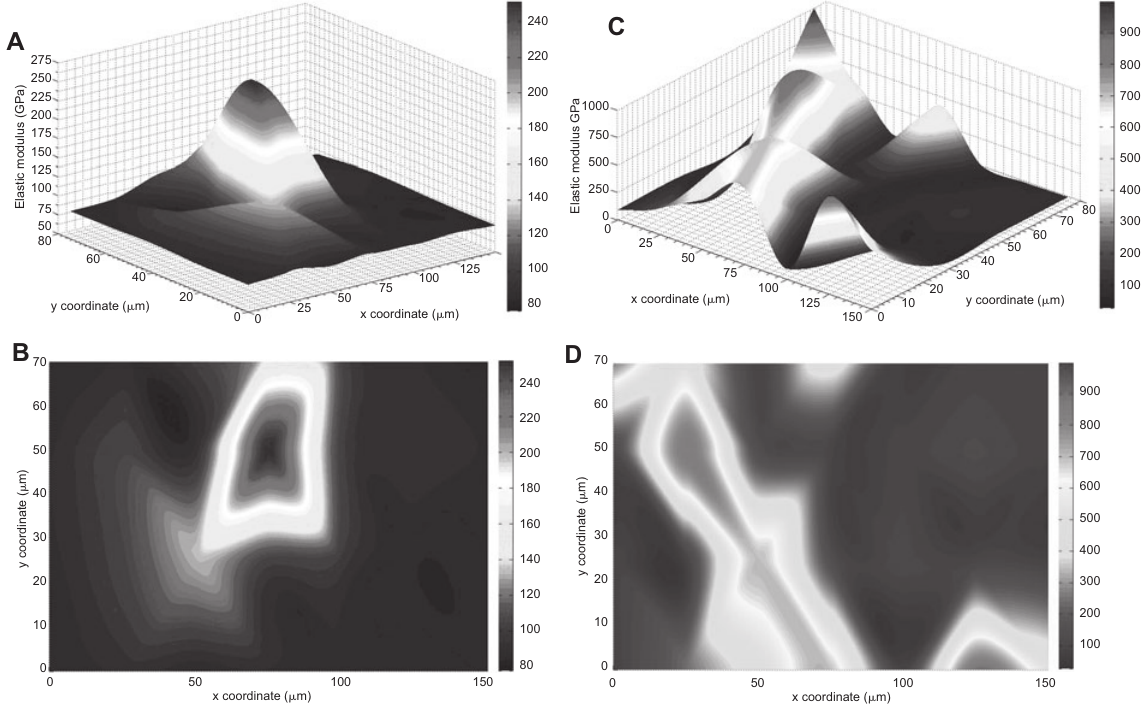
Figure 8 MATLAB plots of the distribution of the elastic modulus in different locations of the area around a particle: (A) elastic modulus particle; (B) contour plot of A; (C) elastic modulus distribution near an AlB distribution near an AlB 2